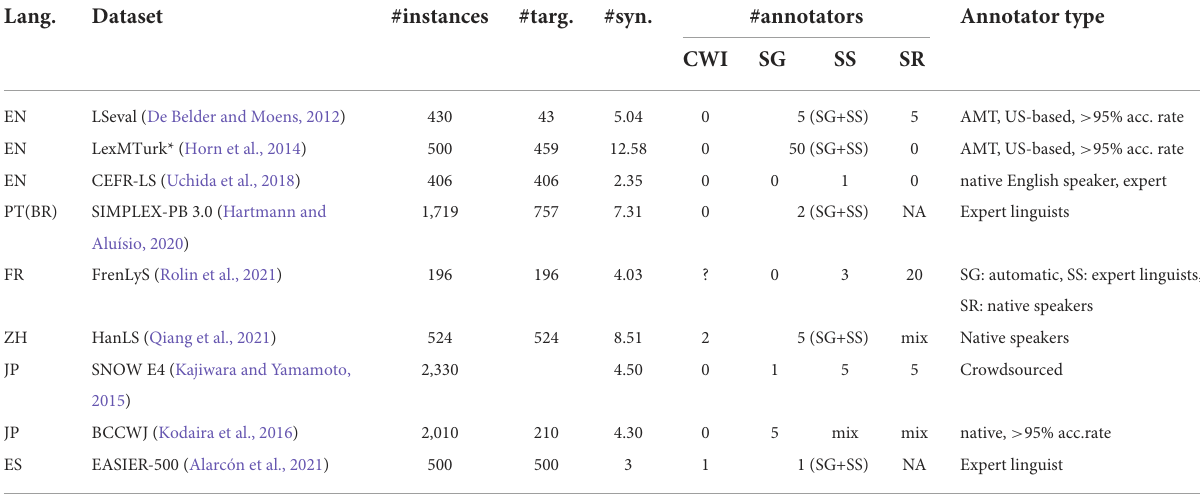
TABLE 1 Datasets used in evaluation of lexical simplification systems.